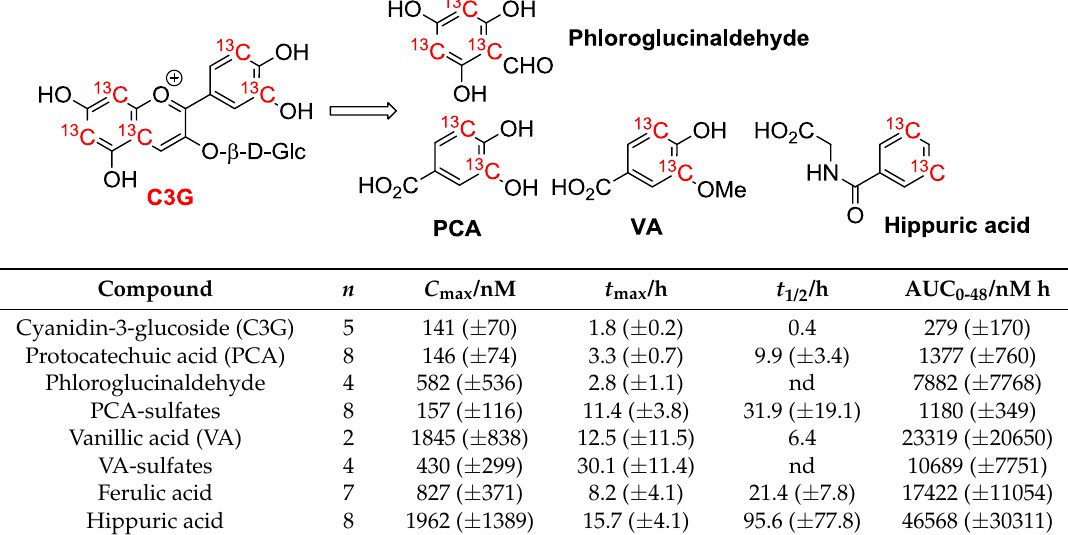
Table 2. Serum pharmacokinetic profiles of cyanidin 3-glucoside (C3G) and its metabolites in humans after the consumption of 500 mg 13 C-labelled C3G. From reference [3] (in red is the reference compound and its most abundant